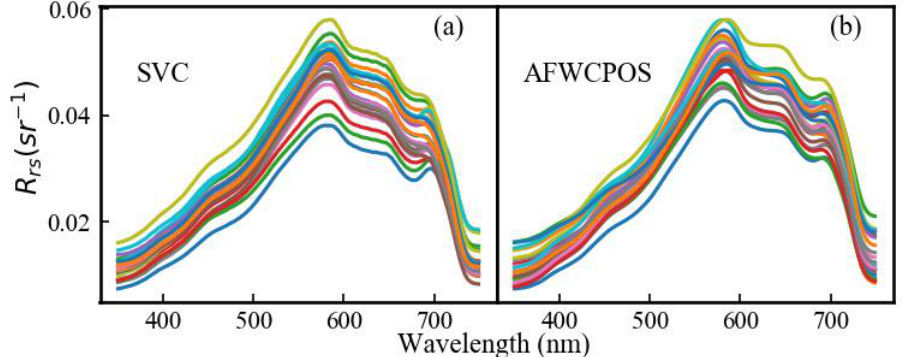
Figure 8. The remote sensing reflectance (Rrs(sr-1)) in Poyang Lake (29°26.75′ N, 116°3.1′ E) from measurements made by ( a ) the SVC (Spectra Vista Corporation) HR1024 and ( b ) the Automatic Stationary Water Color Parameters Observation System (AFWCOS).